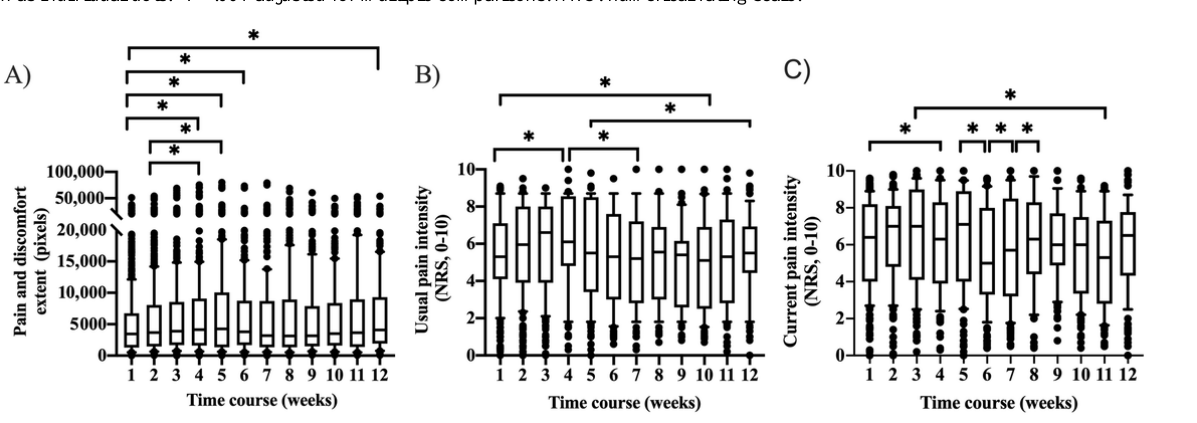
Figure 2. Median (IQR) pain and discomfort extent (A) and usual (B) and current (C) pain intensity ratings, increased and decreased as a group (n=65), in comparison with baseline and throughout the 12 weeks. The lower and upper quartiles, representing observations between the 25th and 75th percentile range, show the median for a month. The whiskers are drawn down to the 10th percentile and up to the 90th. Points below and above the whiskers are drawn as individual dots. * P <.001 adjusted for multiple comparisons. NRS: numerical rating scale.